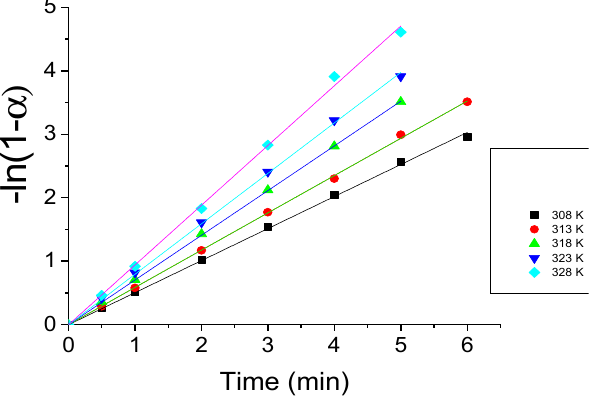
Figure 5. Isothermal dependences of − ln (1 − α ) on time. The isothermal dependences − ln (1 − α ) on time are straight lines at all of the investi- gated temperatures, which confirms the correctness of the chosen kinetic model of release and allows the calculation of the value of k M . The isothermal values of k M are shown in Table 1. Table 1. Effect of temperature on the values of k M and kinetic parameters for SMCH and CH conditions. SMCH T, K